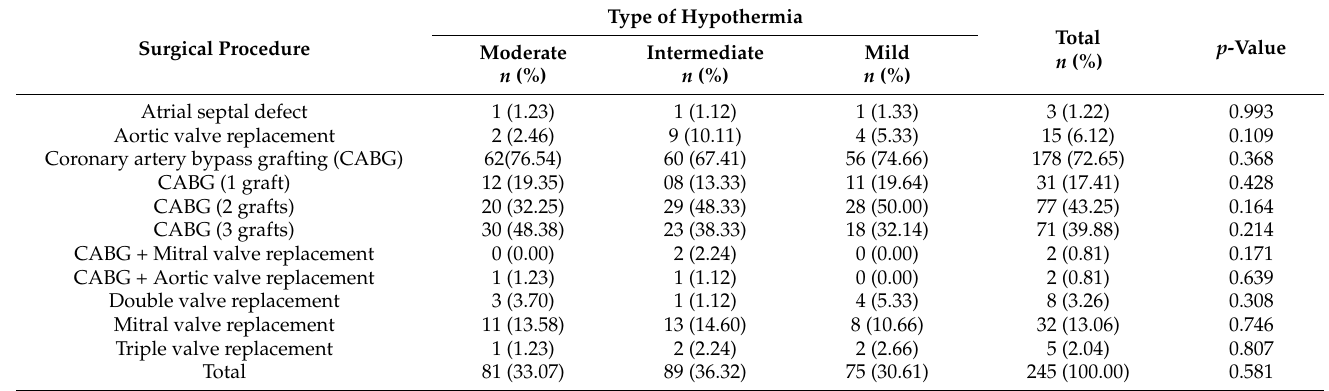
Table 1. Distribution of surgical procedures in hypothermic groups.